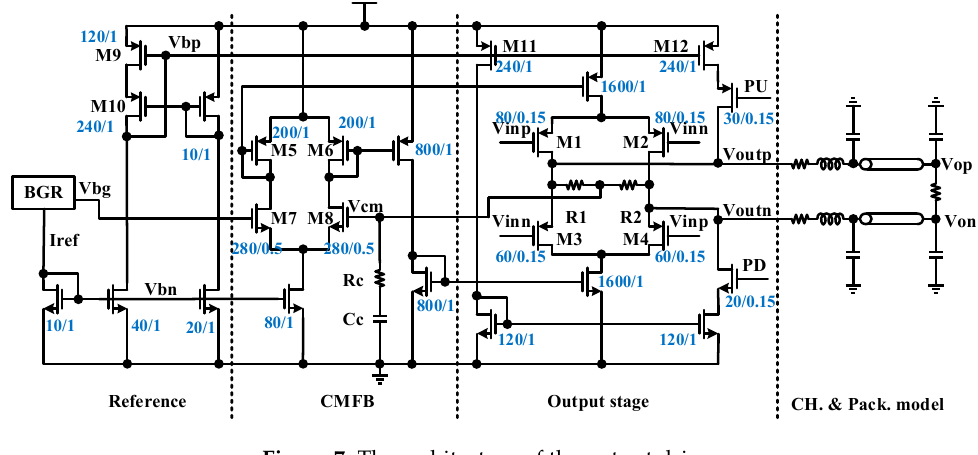
Figure 7. The architecture of the output driver.